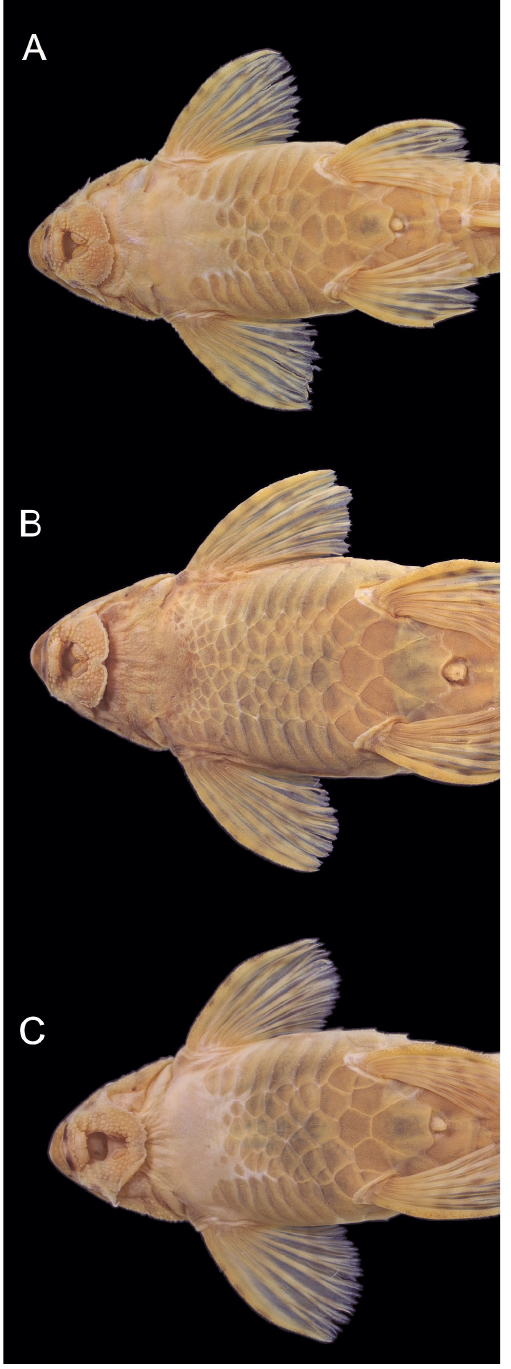
FIGURE 3 | Variation of abdominal plate coverage in the anterior region of abdomen in paratypes of Rineloricaria nudipectoris : A. MNRJ 14844, female, 88.8 mm SL.